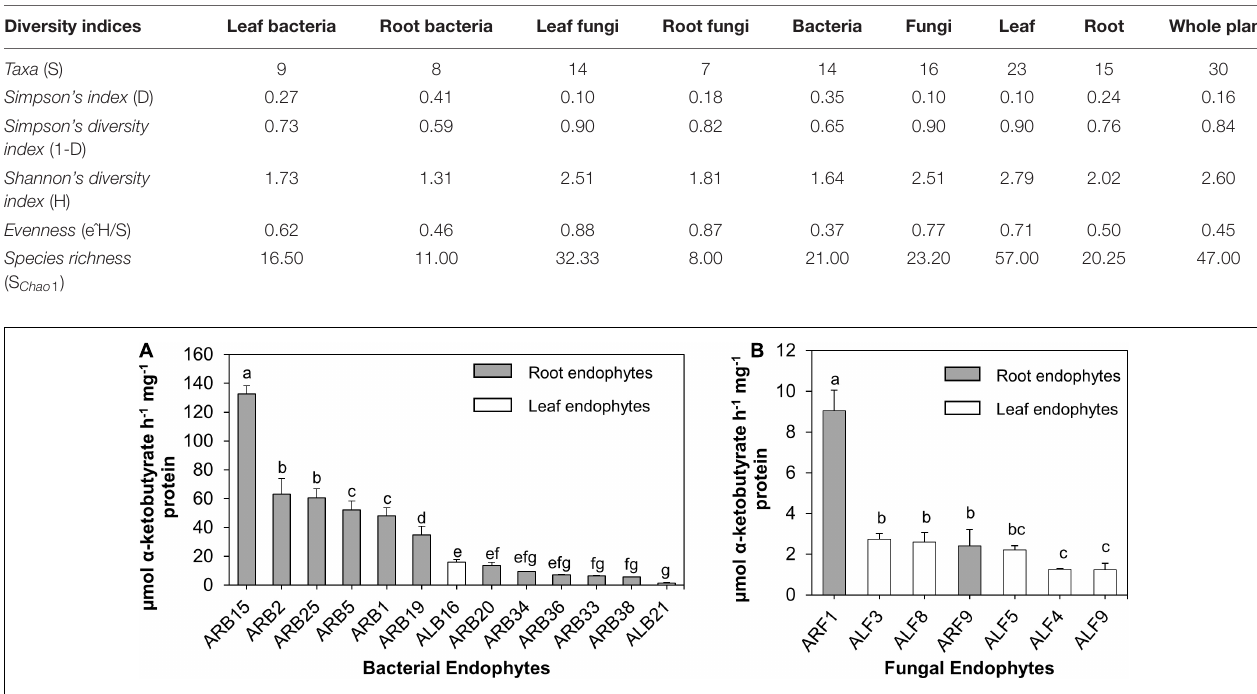
TABLE 1 | Alpha diversity indices of microbial endophytes in different tissues of A. euchroma . Diversity indices